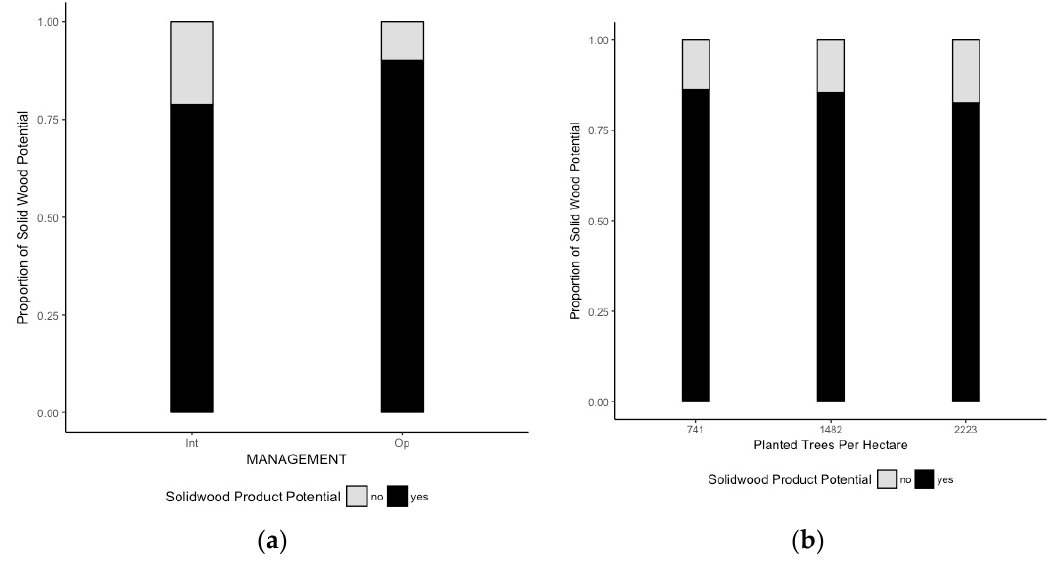
Figure 2. Proportion of solid wood product potential proportions by management intensity ( a ) and planting density ( b ) across six installations of PMRC SAGS Culture × Density non-thinned sites (Int = intensive, Op = operational). Table 6. Generalized linear mixed model, and linear mixed model analysis of deviance table (Type III Wald chi-squared tests) for analysis of solid wood product potential (Model 1), proportion of product-defining defects (Model 2), and heights of product-defining defects (Model 3). Models constructed without interactions. DF = Degrees of freedom, Man. = Management level, TPH = Trees per